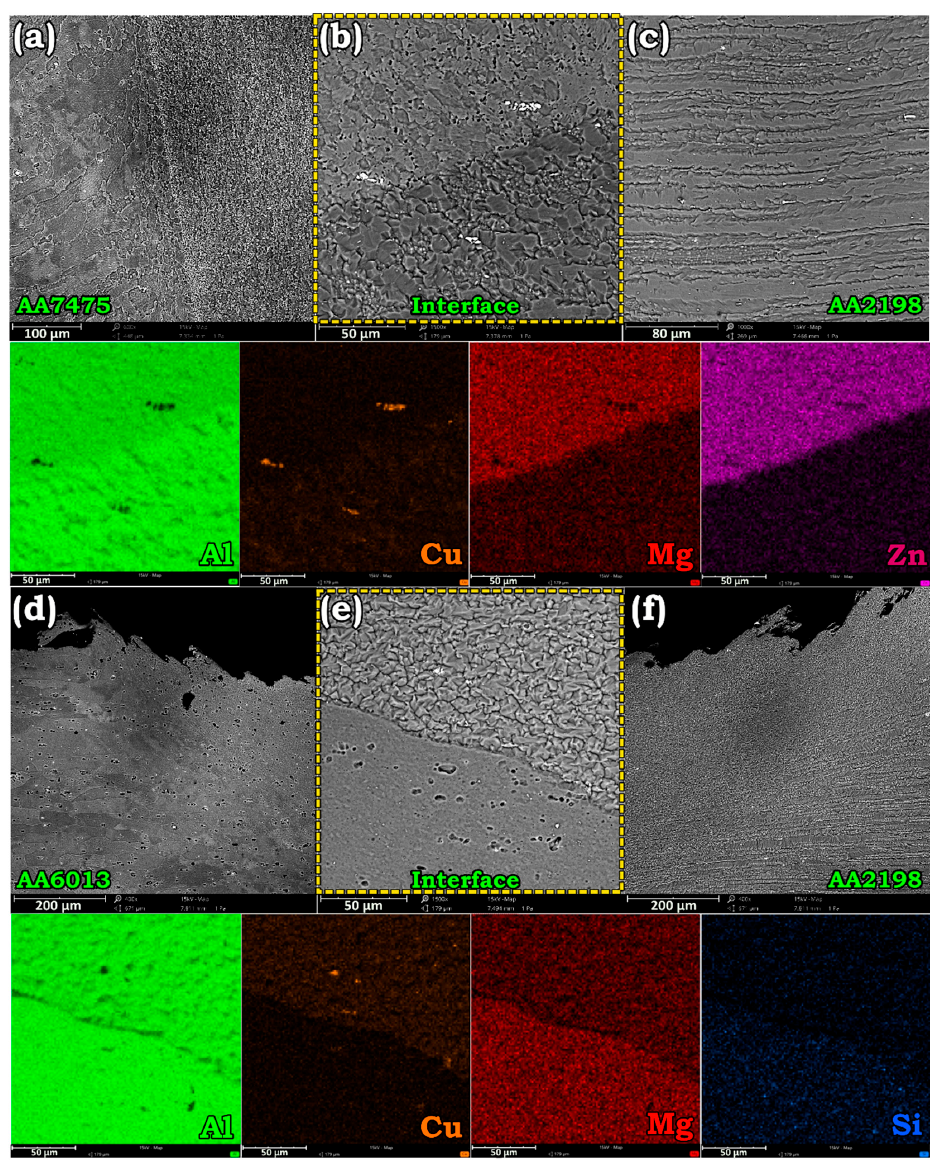
Figure 3. SEM images exhibiting the grain morphology, particle distribution, and maps of constit- uent elements at welding interface of the AA7475-AA2198 ( a – c ) and AA6013-AA2198 ( d – f ) as-weld specimens.